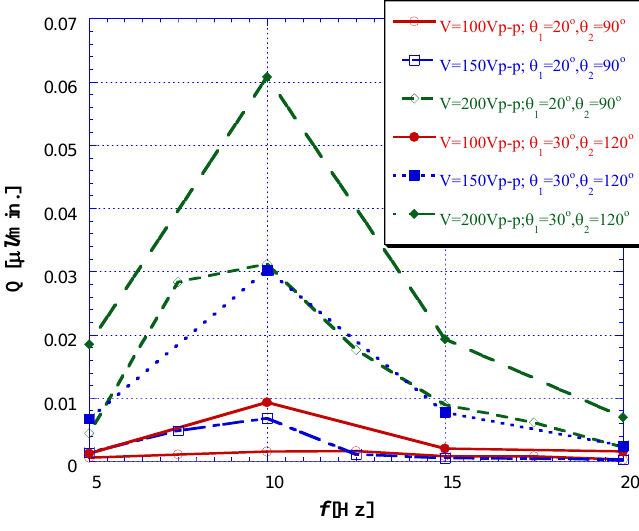
= 30°, θ = 120° and θ = 20°, θ = 90°. 1 2 1 2